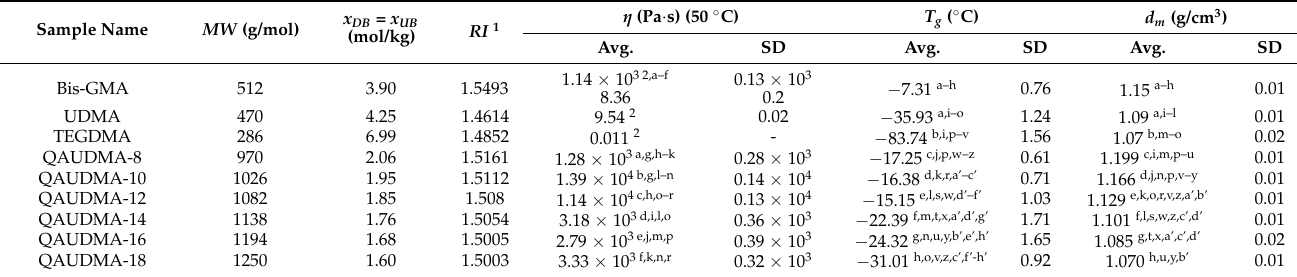
and decreased as the N -alkyl substituent length increased. Table 1. The properties of QAUDMA monomers. Couples that revealed statistically significant ( p < 0.05) results are marked with the letters.